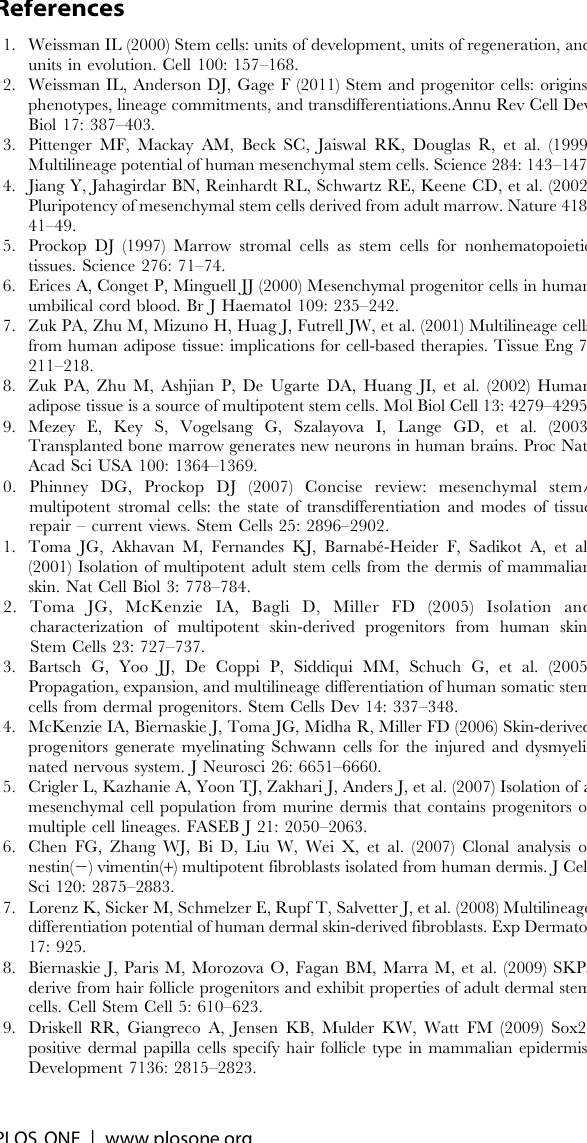
The graphs are shown as the means with error bars indicating S.D. Figure S3 hDSPC-CM had no effects on cell death. NHDFs were incubated with either hDSPC-CM or non-hDSPC- CM for 24 hr and labeled with Annexin V-FITC and propidium iodide (PI). The distribution of apoptotic cells was analyzed using FACSAria II instrumentation. Only PI positive cells are dead (Q1). Cells showing Annexin V and PI double-labeling represent the stage of late apoptosis (Q2). Live cells were not labeled with Annexin V and PI (Q3), whereas Annexin V-labeled cells (Q4) represent the early stage of apoptosis. Ten thousand cells were analyzed for each condition. Control cells (A), cells treated with non hDSPC-CM (B), and cells treated with hDSPC-CM (C) are shown. The data are representative of three independent experiments. Figure S4 hDSPC-CM reduced the level of H 2 O 2 imme- diately after the treatment. Fluorescence signals from Amplex